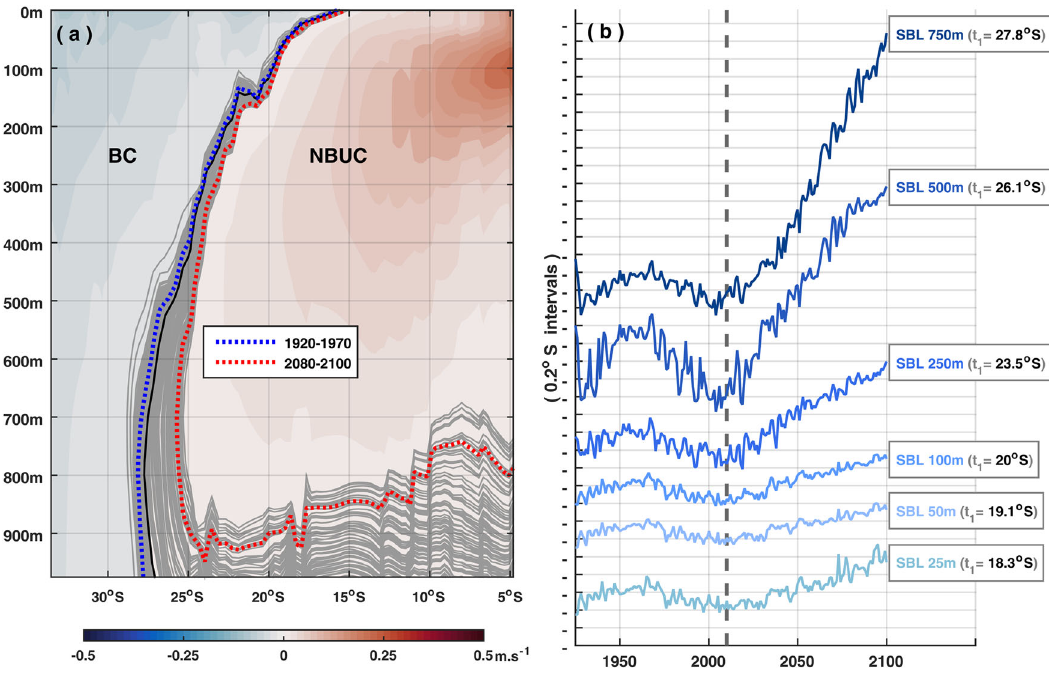
Fig. 6 Equatorward shift of the sSEC bifurcation latitude at the SASG northwestern boundary. a 1920 – 2100 mean meridional velocities averaged over the western boundary layer (<4 ∘ from the South American coast). Positive (negative) values indicate northward (southward) fl ows associated with the NBUC (BC). The bifurcation of the sSEC is represented by the zero meridional velocity line, shown for the mean periods of 1920 – 2100 (black fi lled contour), 1920 – 1970 (blue dotted contour) and 2080 – 2100 (red dotted contour); gray fi lled contours show its annual evolution along 1920 – 2100. b Time series of the sSEC bifurcation latitude at different depths. The value corresponding to the fi rst time step (1920) of each time series is indicated, while the y-axis varies in 0.2 ∘ -latitude intervals (increasing from south to north, thus sign convention is positive upwards for a northward migration of the SBL). The gray dashed vertical line indicates the transition from the historical (1920 – 2005) to the RCP8.5 (2006 – 2100)